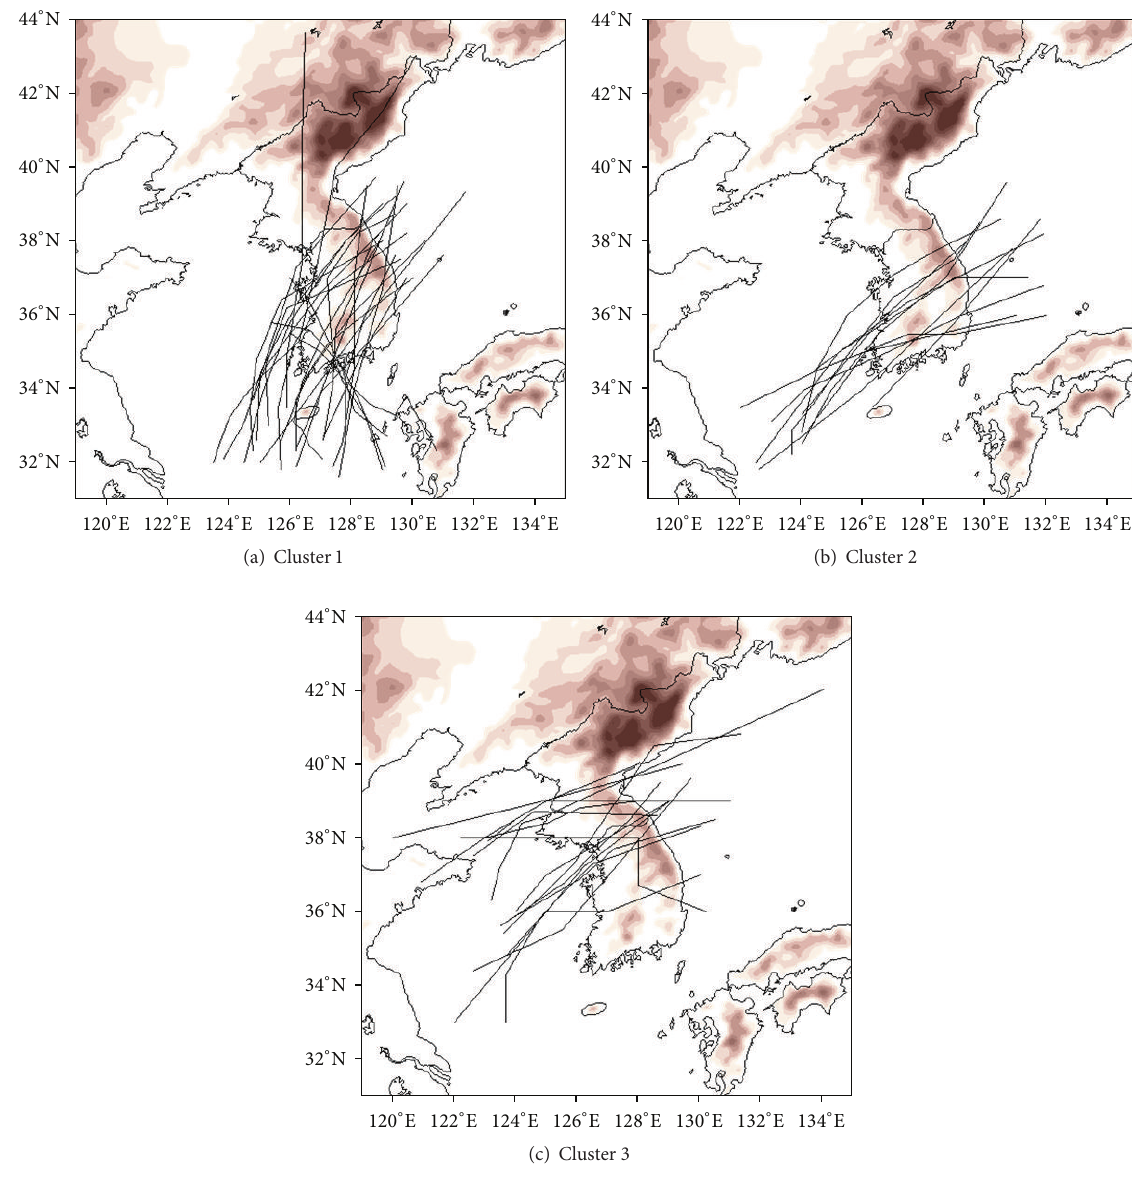
Figure 11: Landfalling tracks of Korea-landfall TCs classified into three clusters. Shaded area indicates topography higher than 200 m above the sea